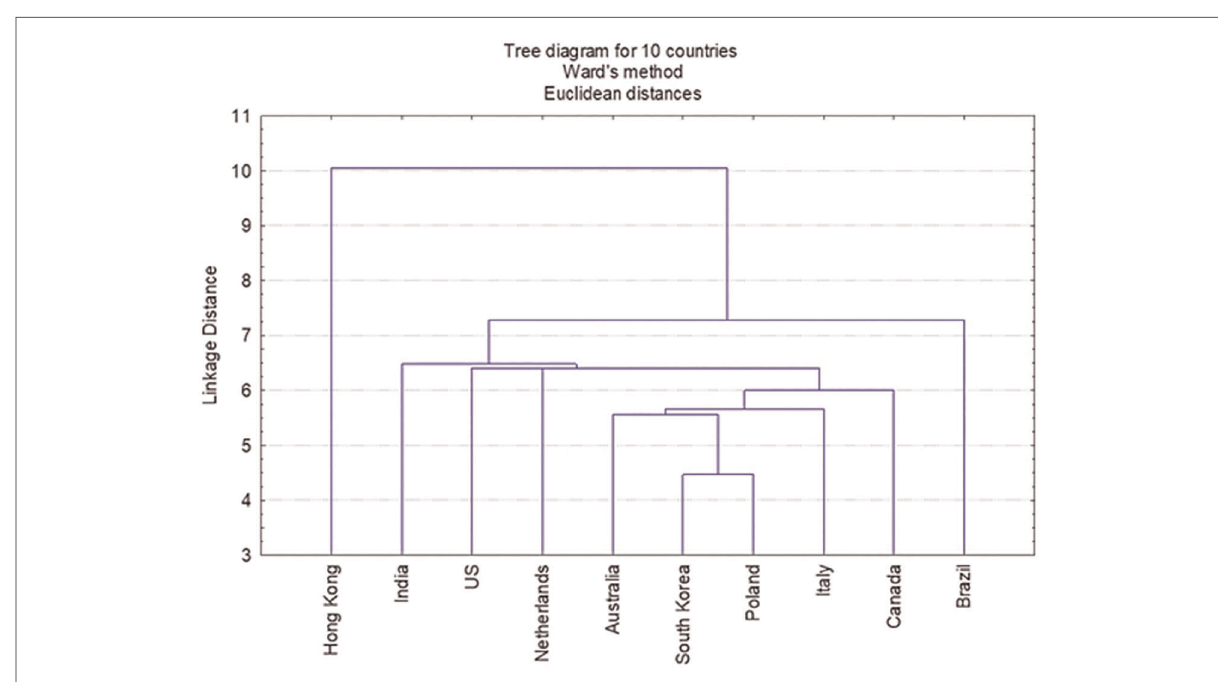
FIGURE 6 Dendrogram of the ten countries clustered by given priority identi fi cation scores.